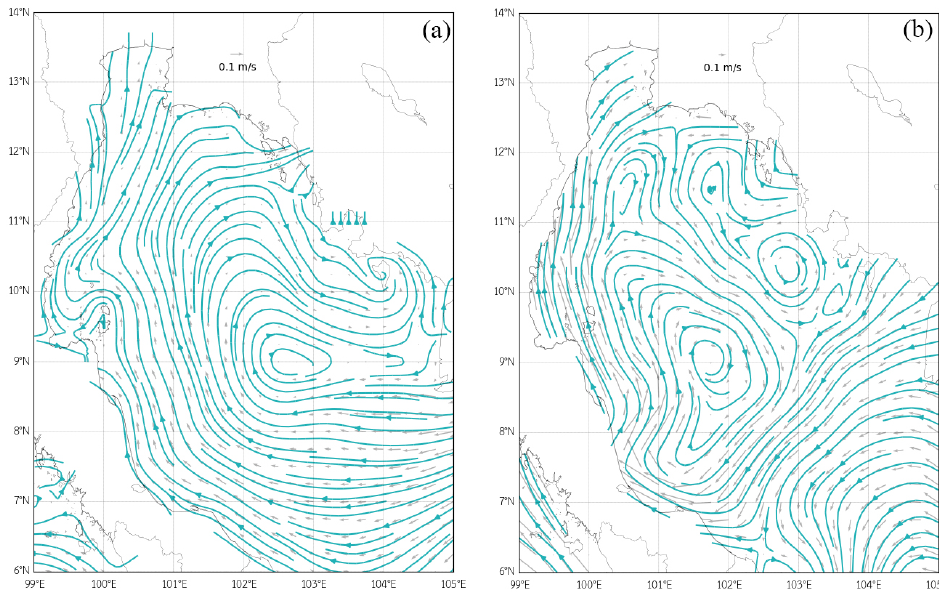
Figure 6. The simulated ( a ) mean surface current velocity from OCM and ( b ) mean surface current from OSCAR in January 2020. The OCM (Figure 7a) simulates the clockwise eddy from 9 ◦ N to 10 ◦ N, and the (Figure